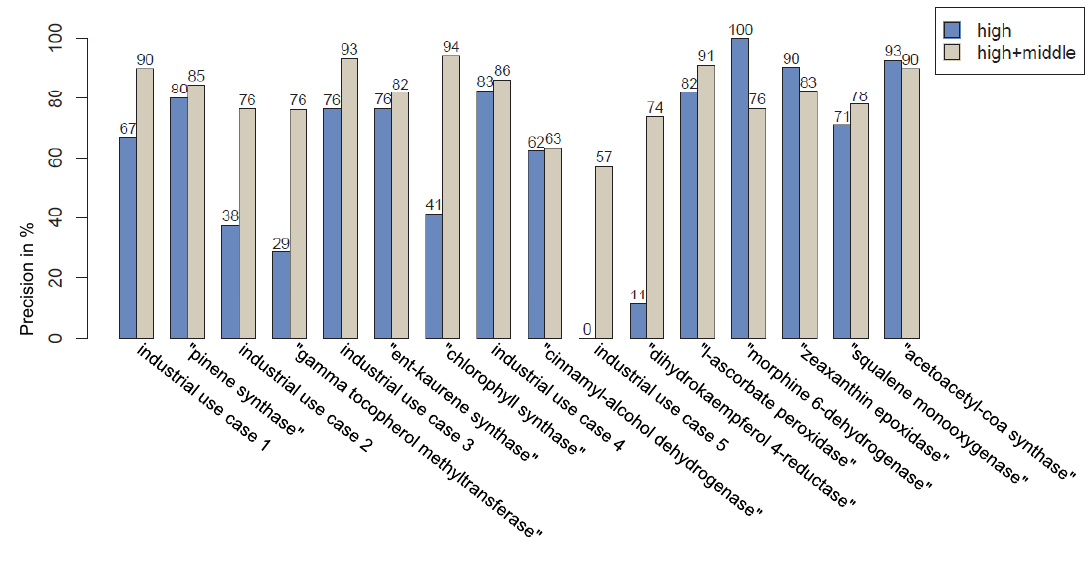
Figure 5: LAILAPS recall for use case